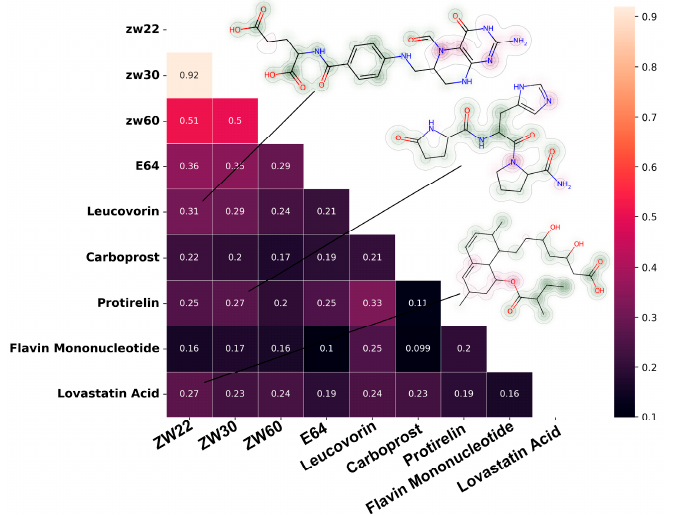
Figure 8. Similarity matrix between candidate molecules and known pS273R inhibitors, the molecule’s fingerprint showed in the upper right corner.